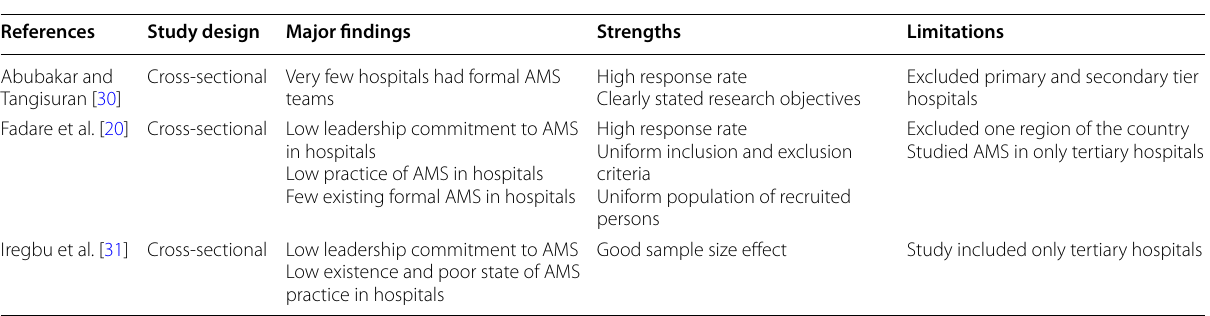
Table 2 Characteristics of studies on status